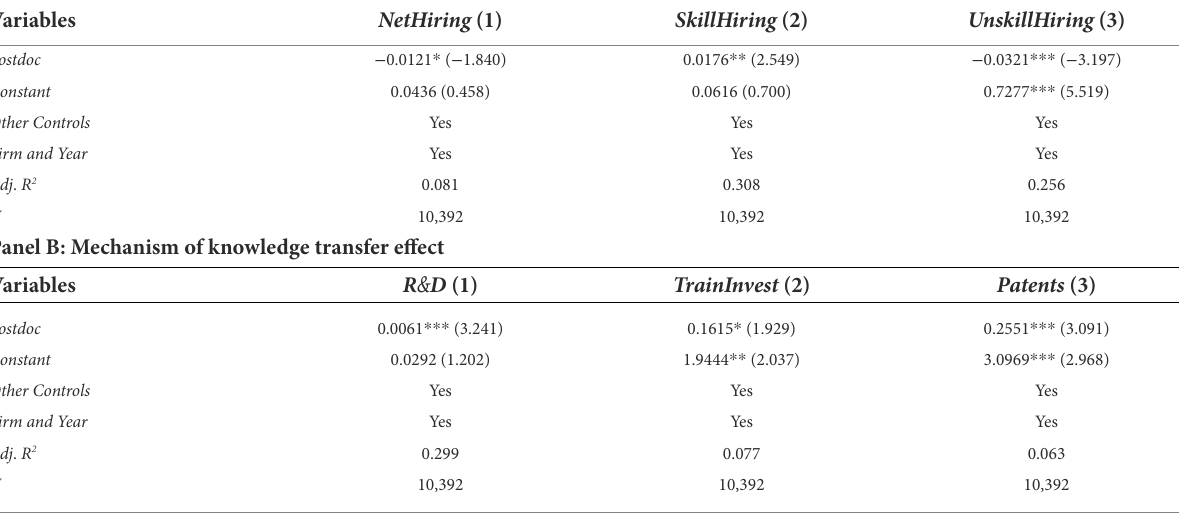
TABLE 8 The potential mechanism. Panel A: Mechanism of brain grain effect